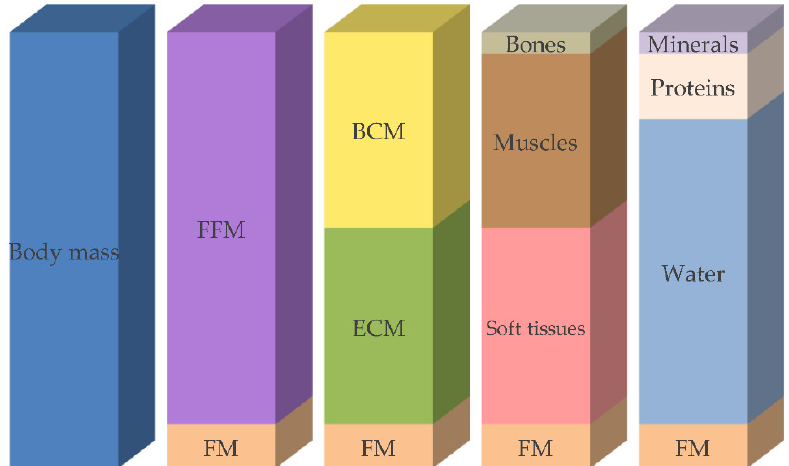
Figure 1. Compartment models of body composition. FFM: fat-free mass, FM: fat mass, BCM: body cell mass, ECM: extracellular cell mass. (Reber E, Gomes F, Vasiloglou MF, Schuetz Ph, Stanga Z. Nutritional Risk Screening and Assessment [Figure 1]. J Clin Med 2019; 8: 1065. Article licensed